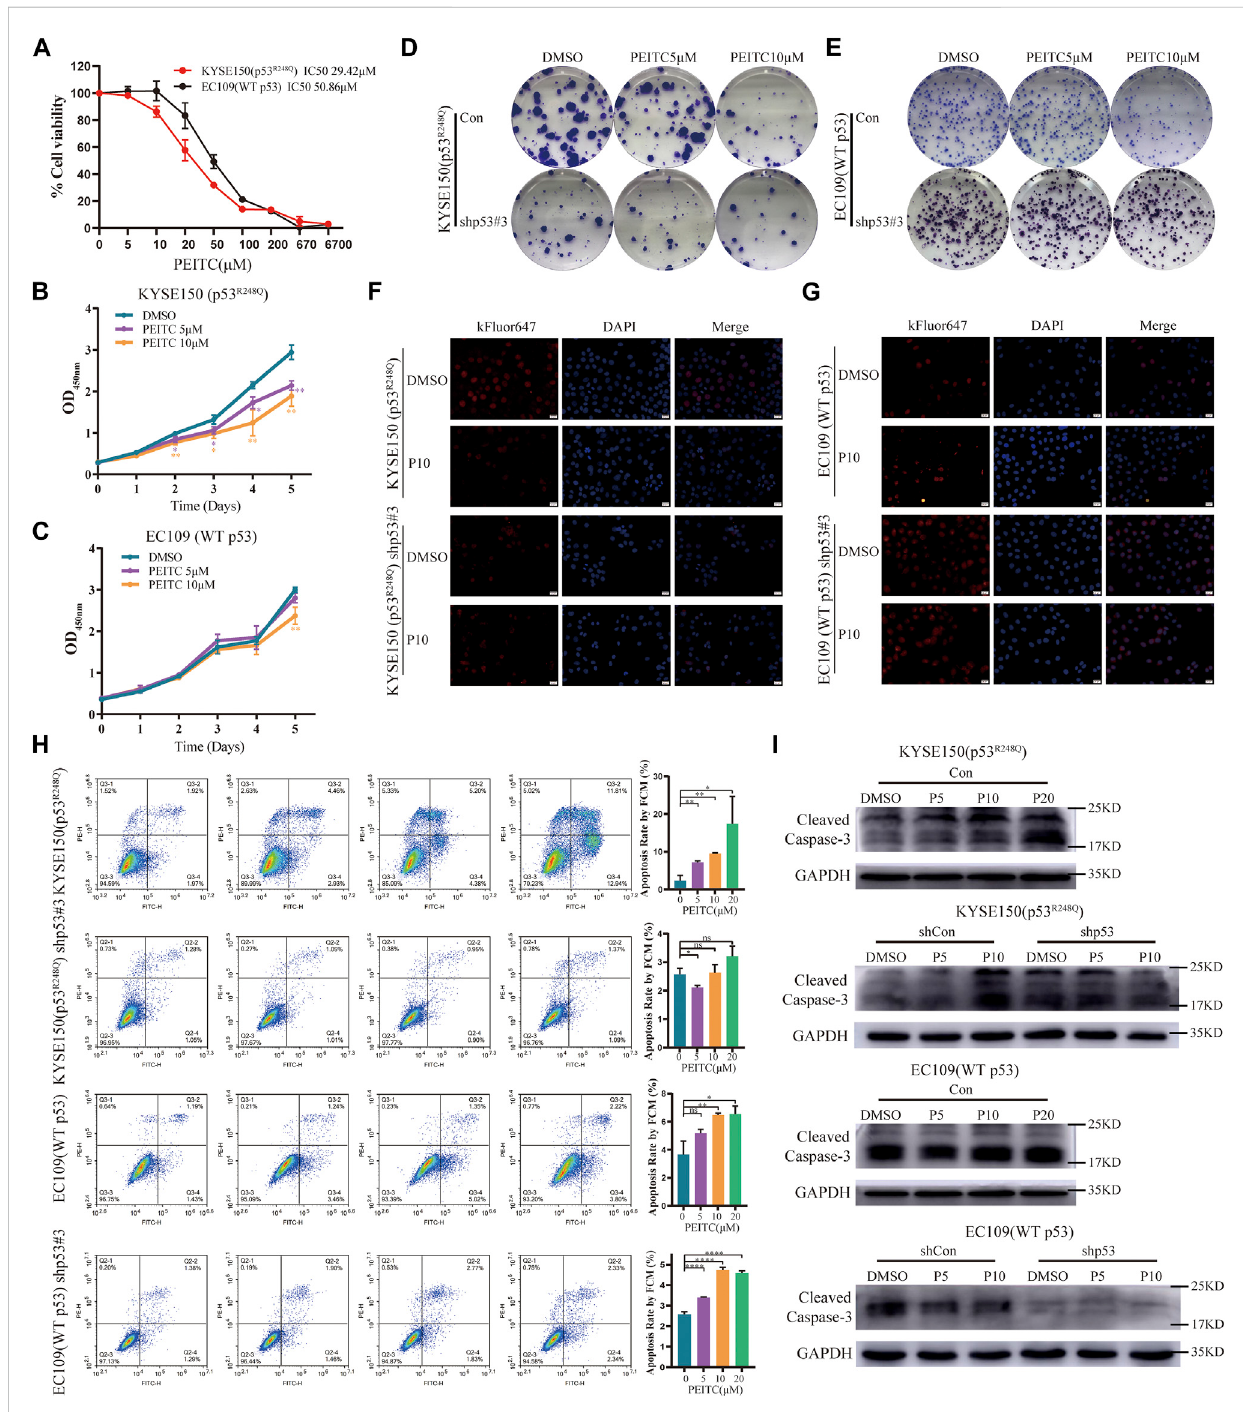
FIGURE 1 PEITC preferentially inhibits the proliferation of p53-mutant ESCC cells, and its effects are p53 R248Q -dependent. (A) Cell viability in each group was measuredbytheCCK-8assay,andtheIC50isindicated.CellslinesweretreatedwithDMSOorPEITCfor2days. (B,C) CCK-8assaytodetecttheeffectof DMSO or PEITC on the proliferation of cells. (D – G) Colony formation and EdU incorporation assays were used to analyze the proliferation of cells after treatment with DMSO or PEITC for 2 weeks or 24h. Scale bar = 20 μ m. (H) Cell apoptosis was detected by fl ow cytometry. Cells were treated with DMSO or PEITC for 12h. (I) The protein expression levels of cleaved caspas3 and GAPDH were measured by Western blot analysis. * p < 0.05; ** p < 0.01. P5, PEITC 5 μ M; P10, PEITC 10 μ M. The cell experiment was repeated three